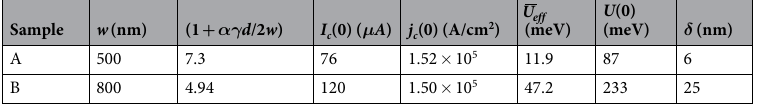
Table 2. Parameters of nanostrips, U (0) is the pinning potential at T = 0, corrected for W f (Equation